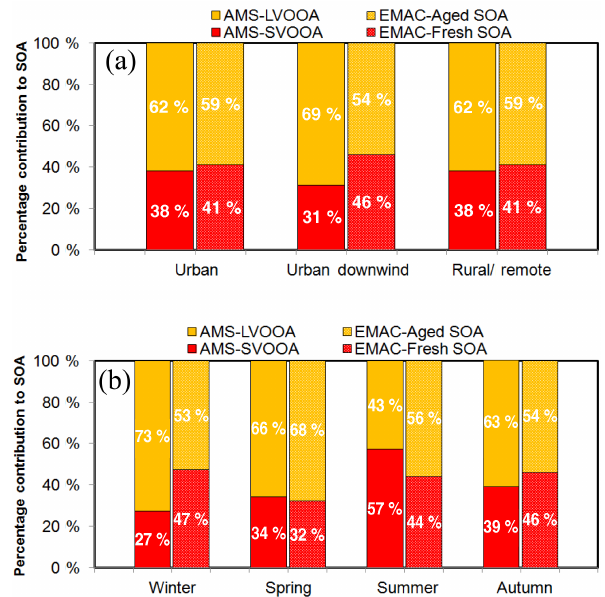
Figure 15. (a) Spatial and (b) seasonal composition of SOA and OOA mass calculated from EMAC and AMS results, respectively, in the Northern Hemisphere during